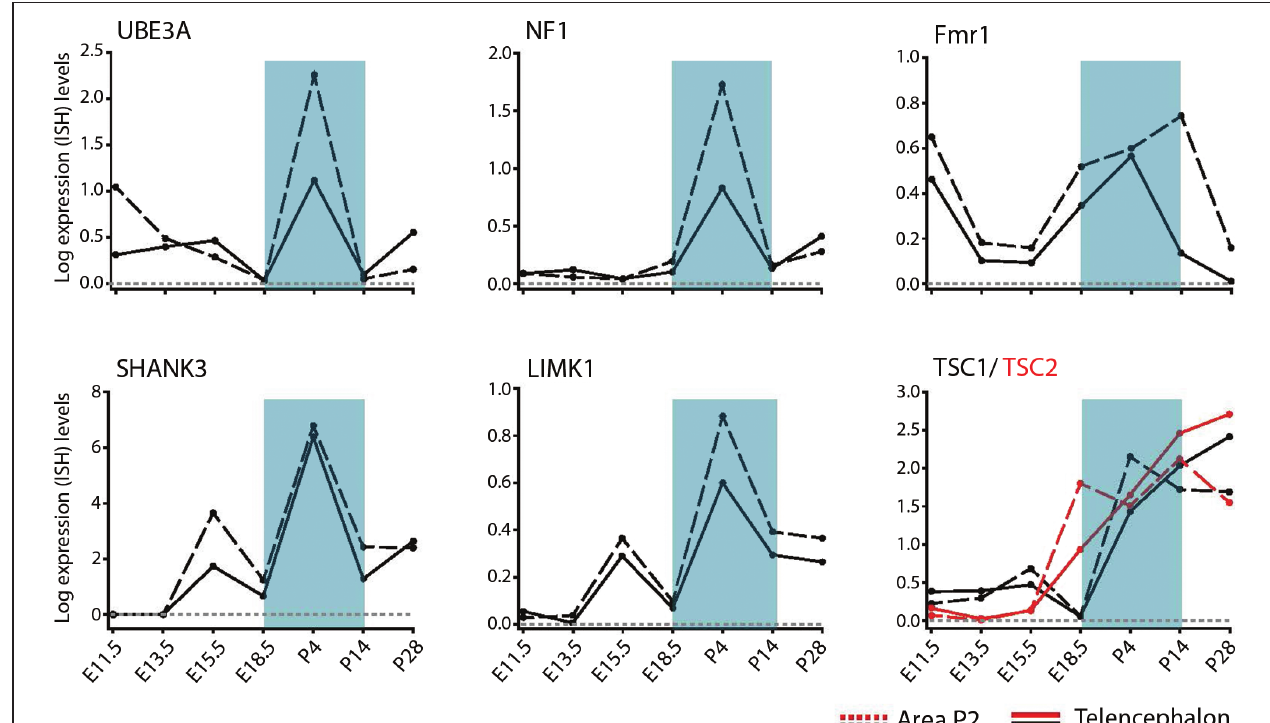
FIGURE 3 | Temporal regulation of genes for syndromic NDDs during pre- and postnatal brain development . Developmental profiles of RNA levels for specific monogenic ID and ASD genes in pre- and postnatal development, in telencephalon and thalamic (Area P2) regions. Data extracted from Allen Developing Mouse Brain Atlas Website: © 2012 Allen Institute for